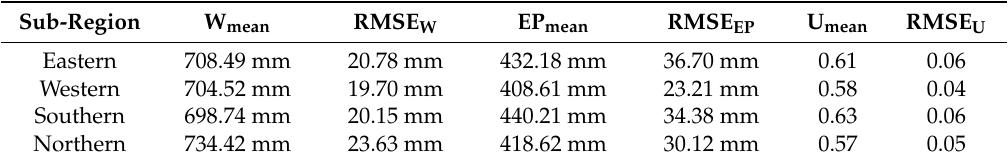
Table 5. The statistics of water balance and water suitability